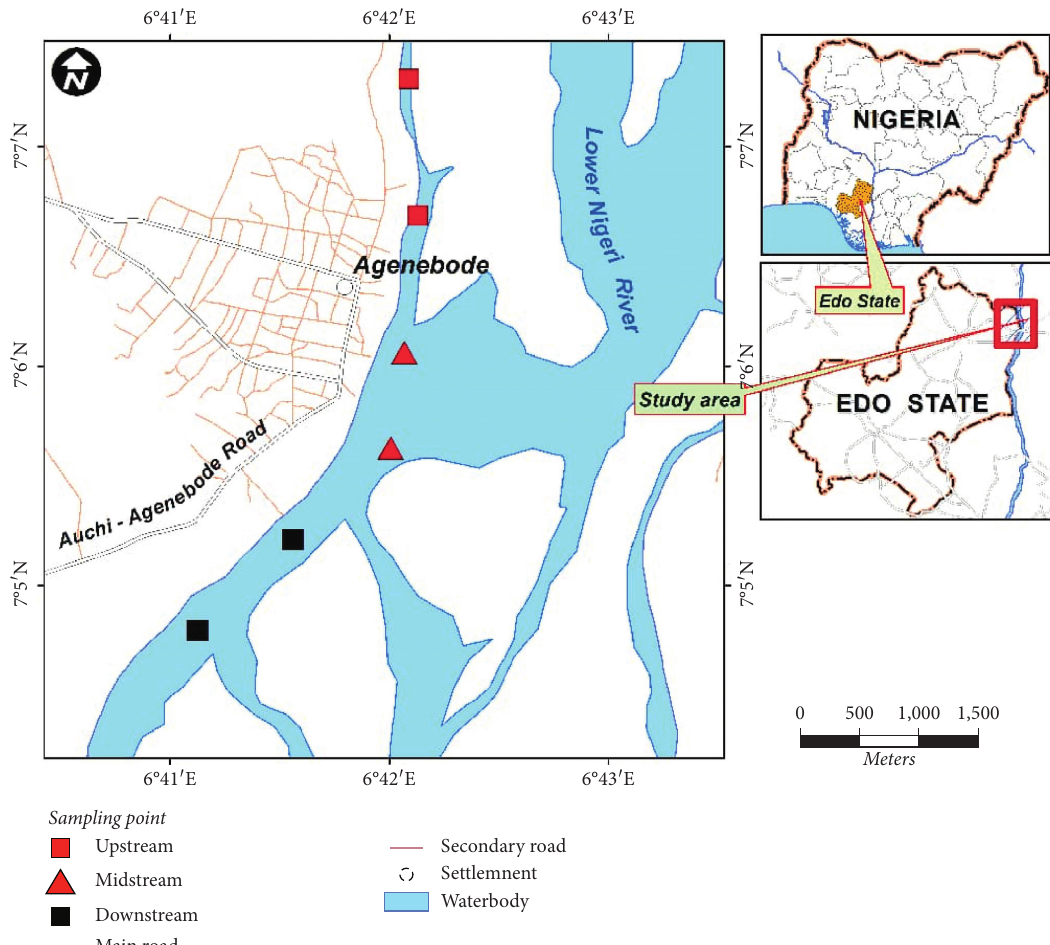
Figure 1: Map of the Lower Niger River showing study